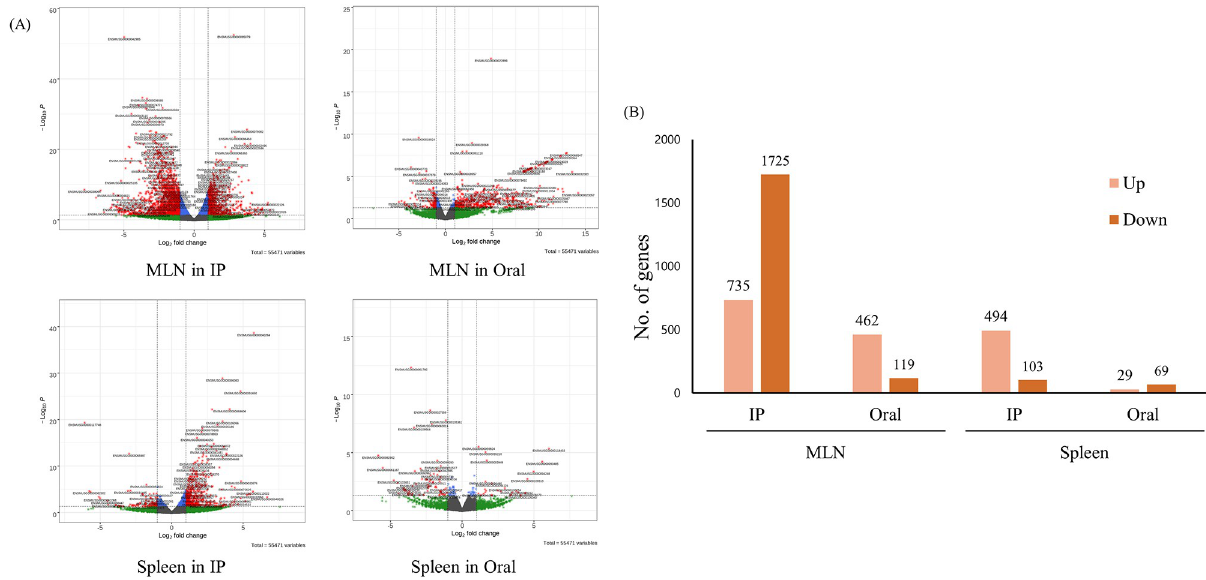
Fig 3. Comparison of gene expression levels between control and MAP-infected mice at 6 weeks PI according to different administration routes and organs. (A) Volcano plot analysis of DEGs in the MLN and spleen of the IP group and oral group. Red dots indicate an expression level change of fold change � |2.0|, and green dots indicate a p value < 0.05. The expression levels were calculated using Cuffdiff from each sample. (B) The number of differentially expressed genes between control and MAP-infected mice according to different administration routes and organs.